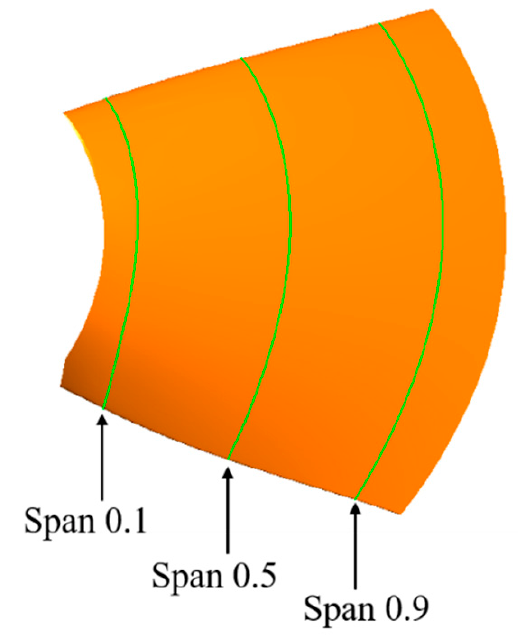
Figure 11. Schematic diagram of the different span line positions.